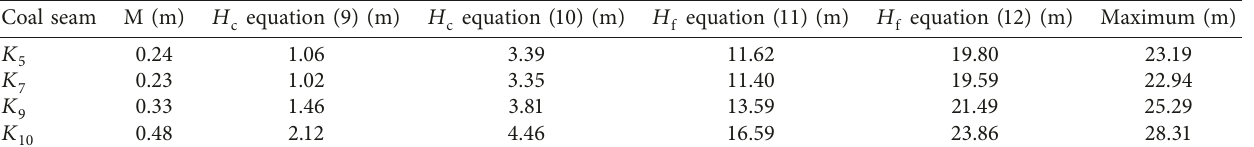
Table 3: The caved and fissure zone height.